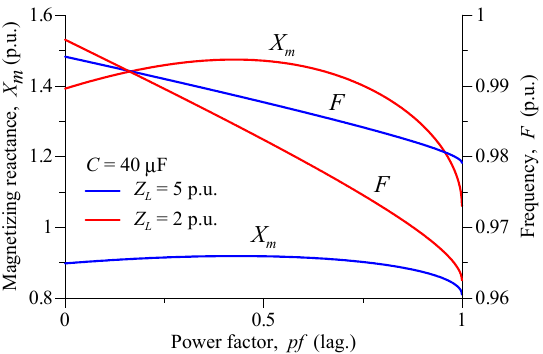
Figure 9. Variation of magnetizing reactance X m and frequency F versus power factor pf for different loads at fixed speed ( u = 1.0 p.u.).